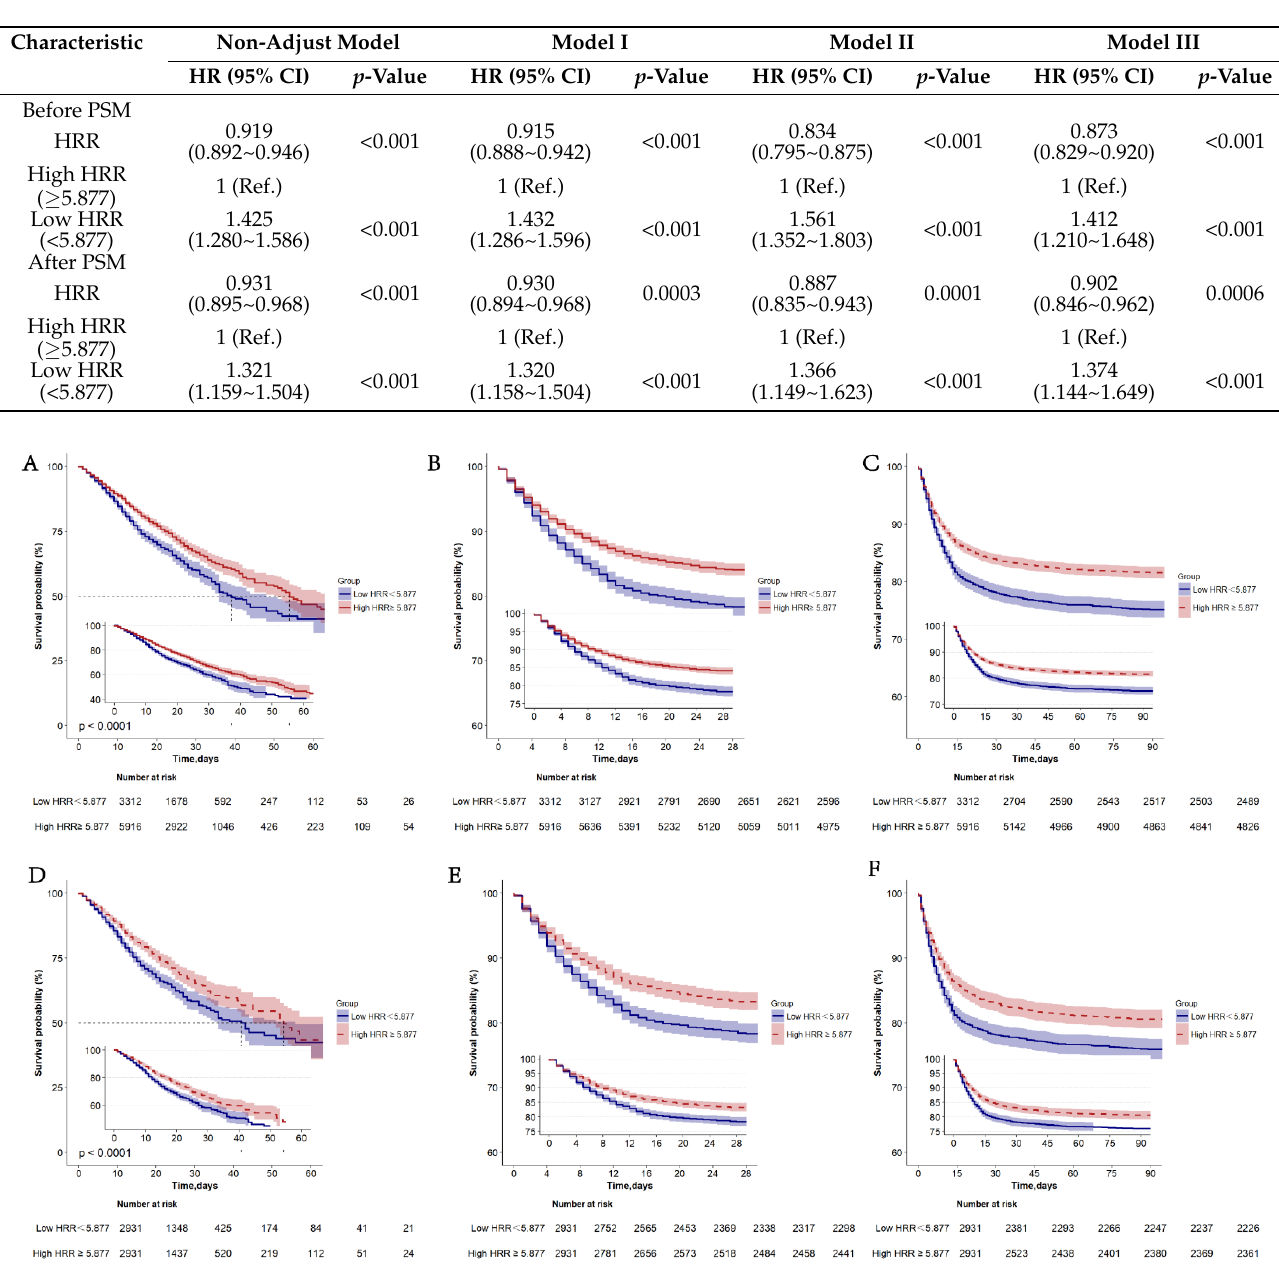
Table 3. Multivariable Cox regression analyses for in-hospital mortality in septic patients with atrial fibrillation before and after PSM.